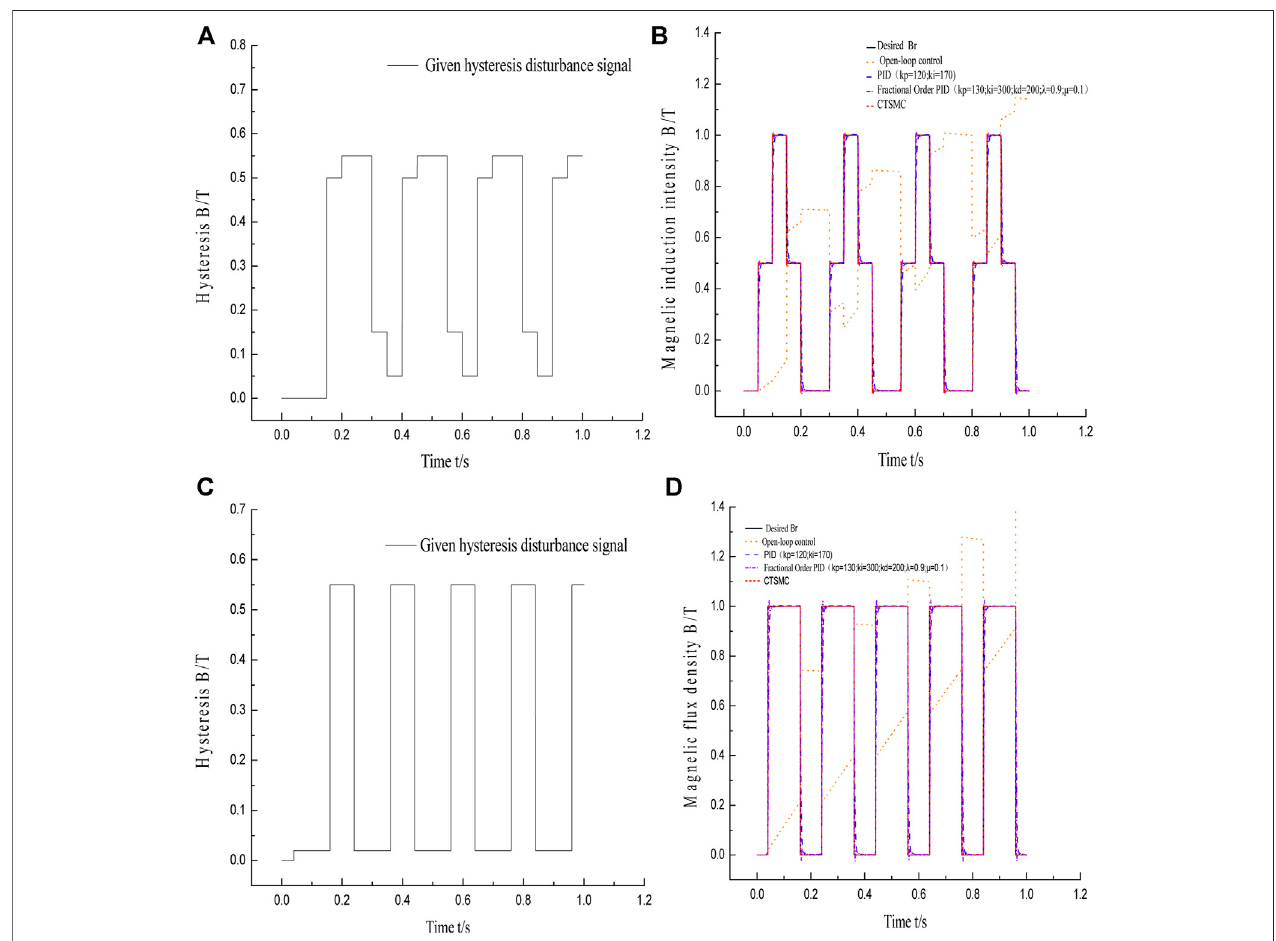
FIGURE 14 | Four control responses of different high-frequency input signals. (A) Hysteresis curve. (B) Response of four controlmultistep functions. (C) Hysteresiscurve. (D) Response of four control window functions.